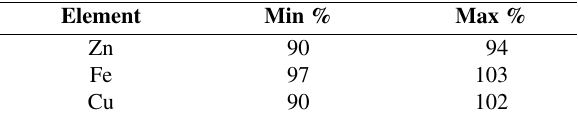
Table 4. Recoveries of spiked (10 and 50 μg L –1 ) Zn, Fe and Cu in milk samples from lactating mothers